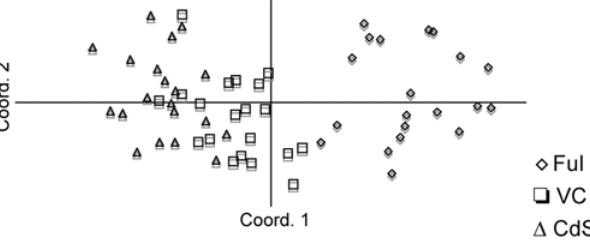
Figure 5. Principal coordinate analysis. Principal coordinate analysis shows significant differentiation between isolated (FuI)